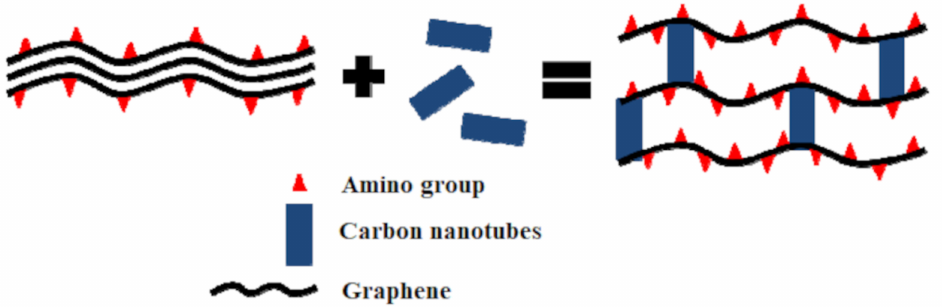
Figure 3. The potential mechanism of carbon nanotubes-enhanced graphene aerogel for formalde- hyde removal